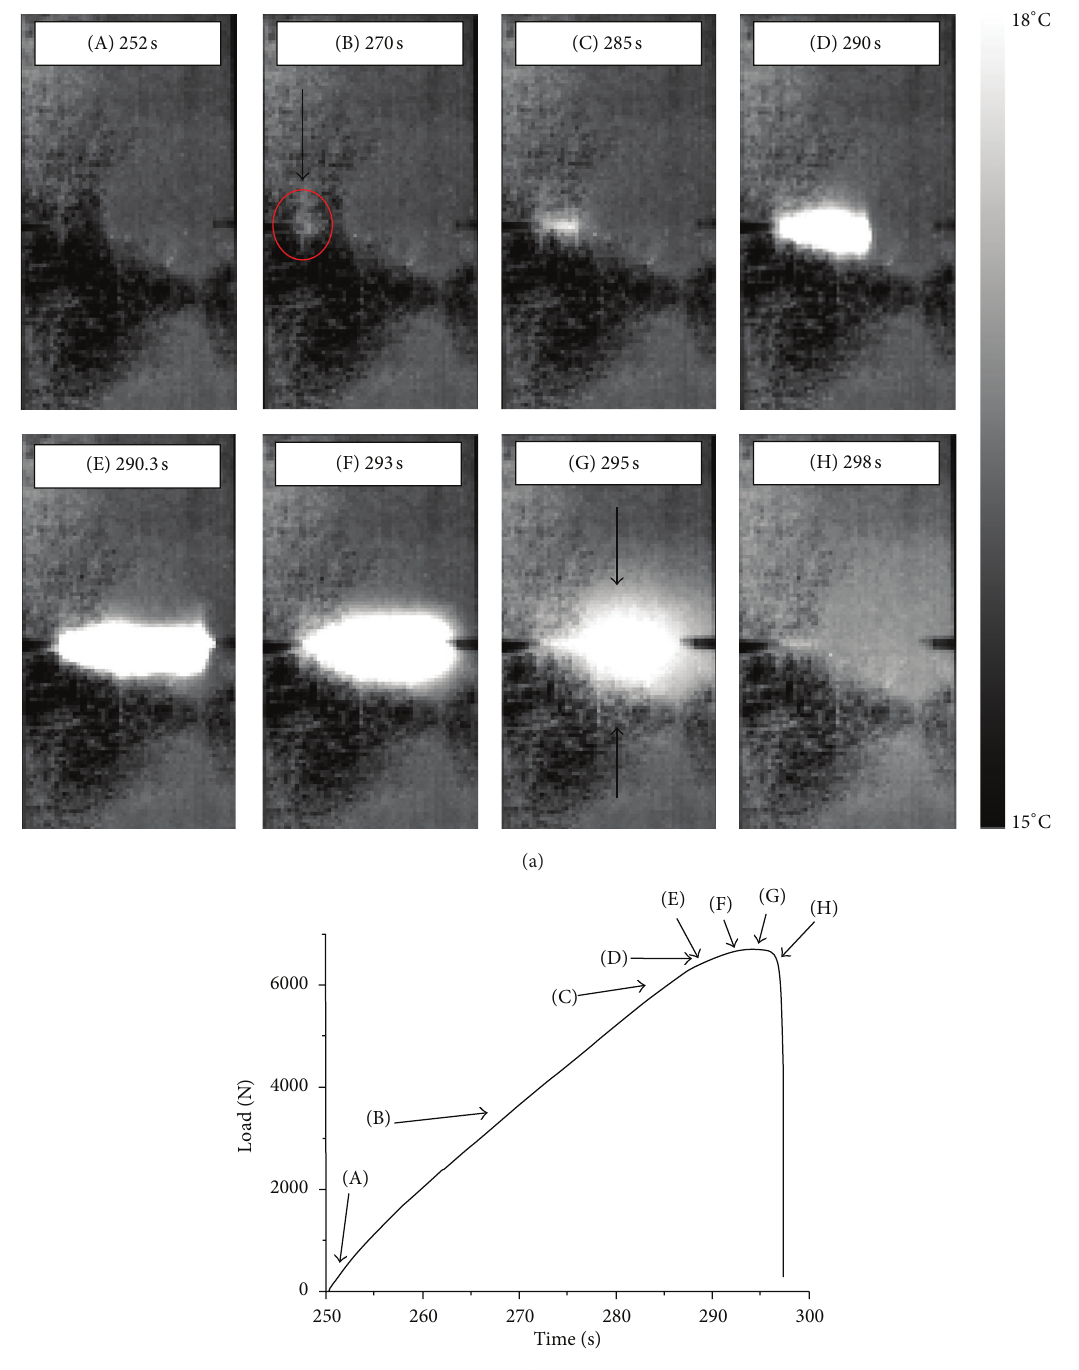
Figure 5: Final loading cycle of 0.35 notch-to-width ratio DEN specimen. (a) Thermographs showing crack propagation and (b) load versus time